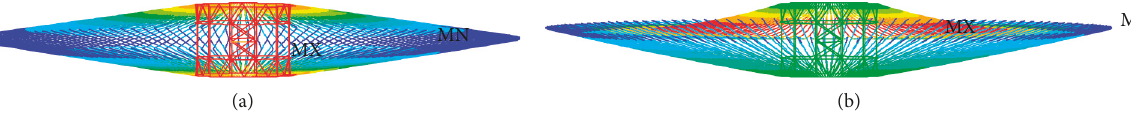
Figure 25: The final displacement of steel cable structure (a) under natural fire and (b) under standard ISO fire.